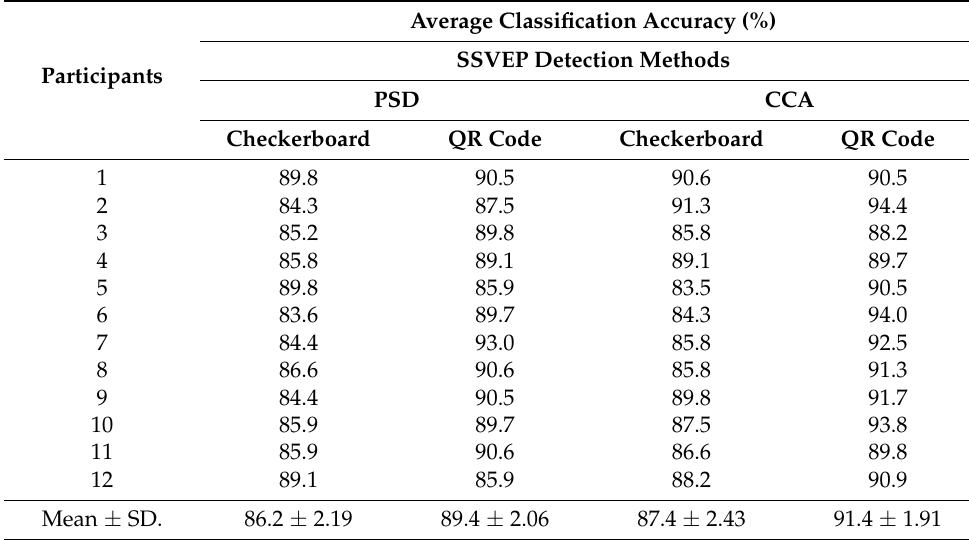
Table 4. Results of average classification accuracy of SSVEP detection methods from different flicker patterns of the checkerboard and QR code patterns for each participant.